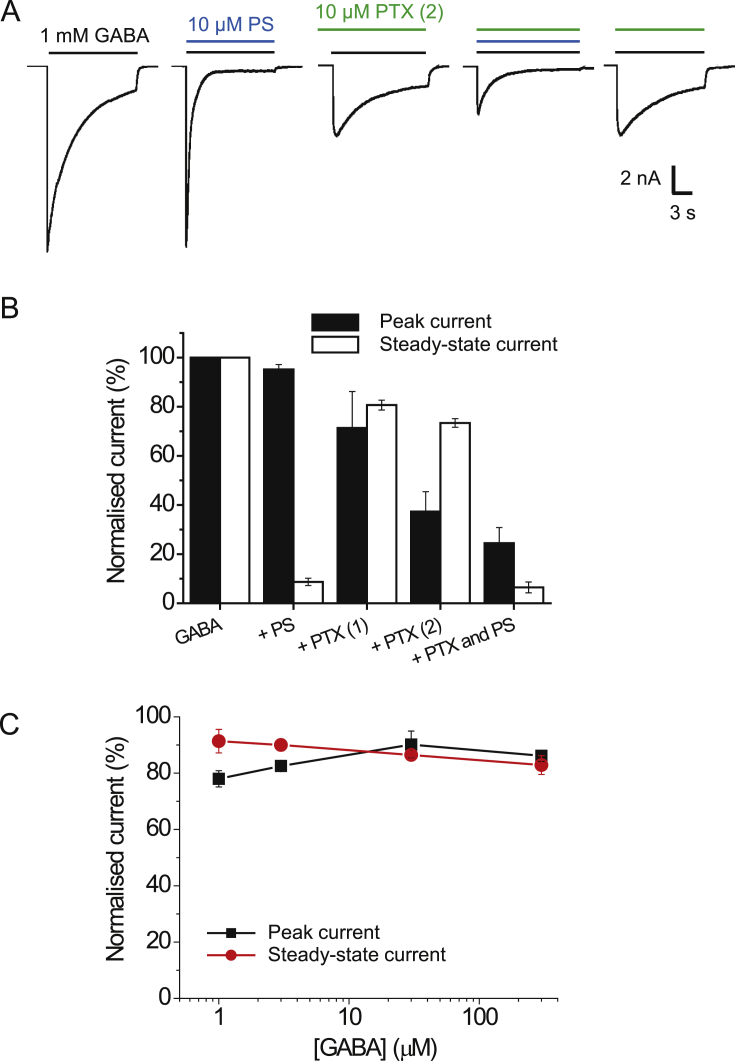
PS and picrotoxin (PTX) do not compete for a common binding site on α1β2γ2L receptors; and activation-dependence of block at ρ1-subunit containing receptors.(A) GABA EC100 (1 mM) current responses for α1β2γ2L receptors when GABA is applied alone, and co-applied with 10 μM PS, 10 μM PTX or both. Note PTX was also pre-applied. The response to GABA shown following pre-application of PTX represents the second (2) such response to ensure PTX inhibition is at equilibrium. PTX was continuously kept in the bath from the start of the PTX applications until the end of the experiment. (B) Bar graph showing responses of α1β2γ2L receptors to GABA, PS and PTX (1st and 2nd consecutive responses) as described in (A) (n = 5). Data are expressed as mean ± SEM. (C) GABA concentration profile for PS inhibition of ρ1 homomers using co-application of 30 μM PS with various concentrations of GABA. There is minimal inhibition of either peak or steady-state currents (n = 7).